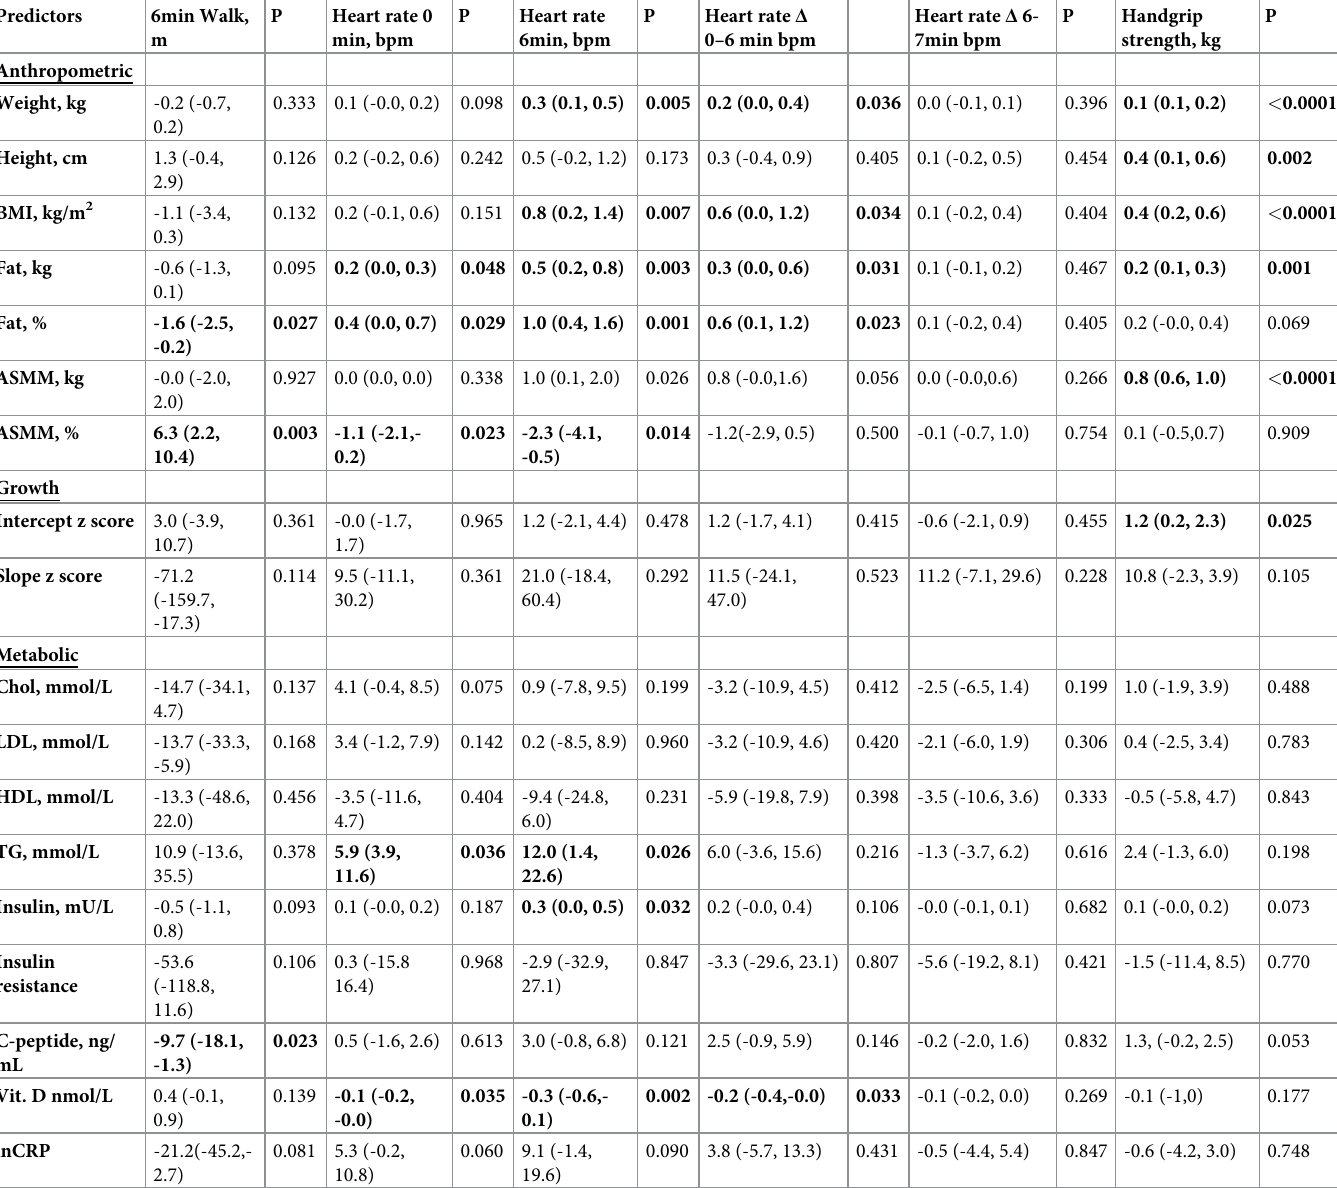
Table 2. Predictors of physical function measures for 98 girls by linear regression adjusted for